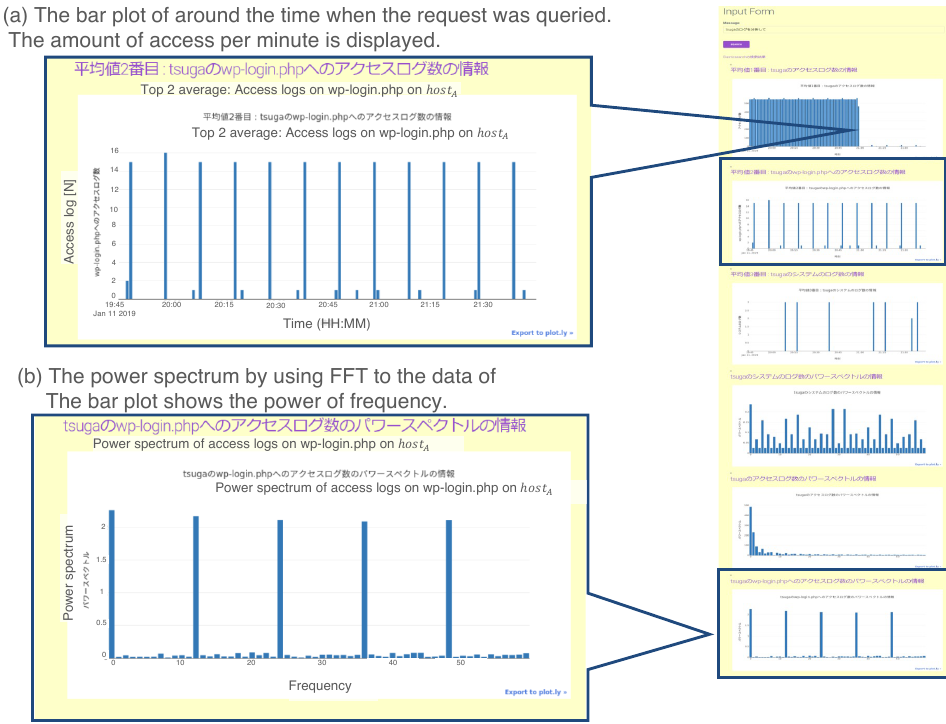
Figure 15. Example result for the prototype system in Case 4. Two results are as follows: ( a ) The bar plot of the time when the request was queried. The amount of access per minute is displayed. ( b ) The power spectrum using DFT on the queried data. The bar plot shows the power of the